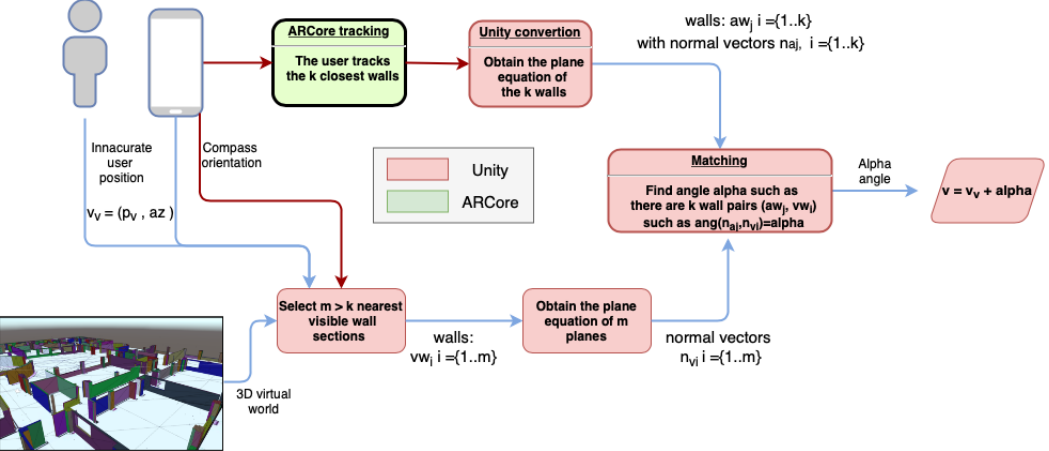
Figure 7. Matching wall process using two walls and orientation correction.